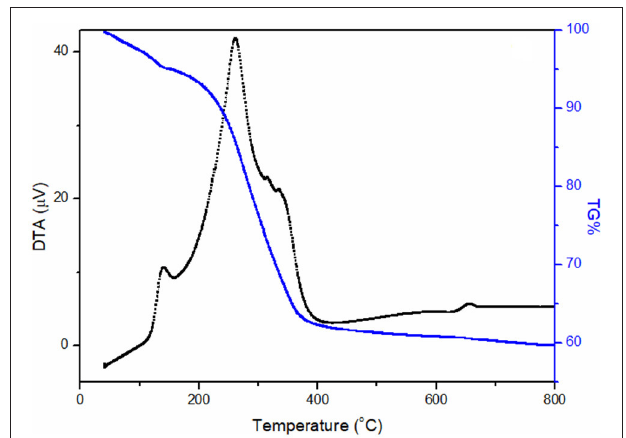
FIGURE 3 | Thermal (DTA, black) and thermogravimetric (TG%, blue) analysis of γ Fe